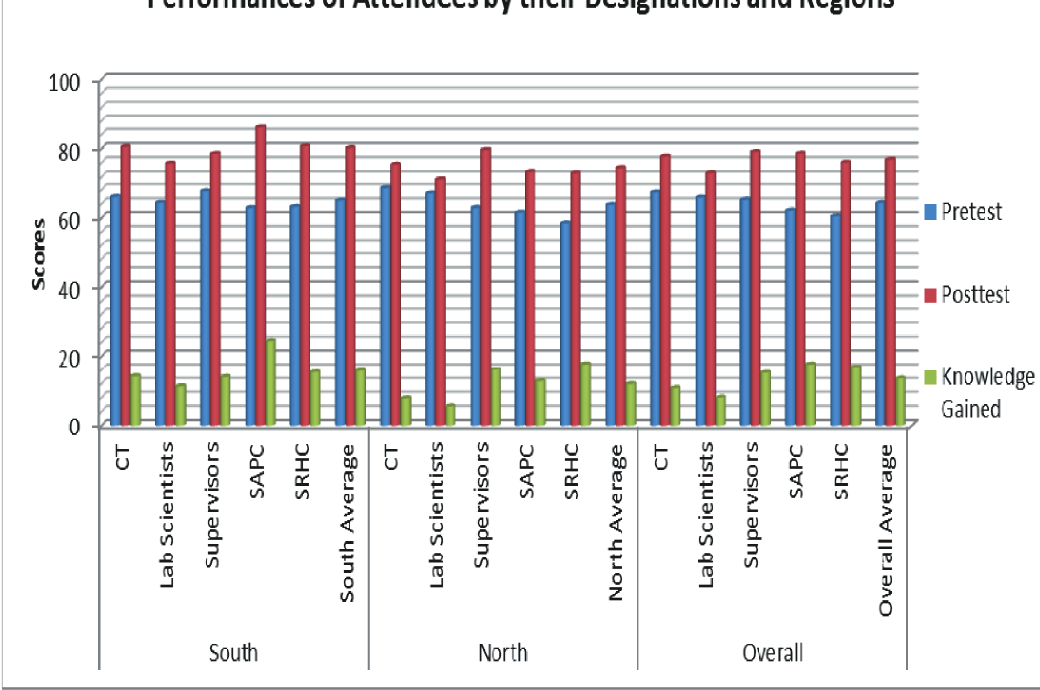
Table 5. Variability in performances of attendees across the various groups Sum of Squares df Mean Square F Sig.